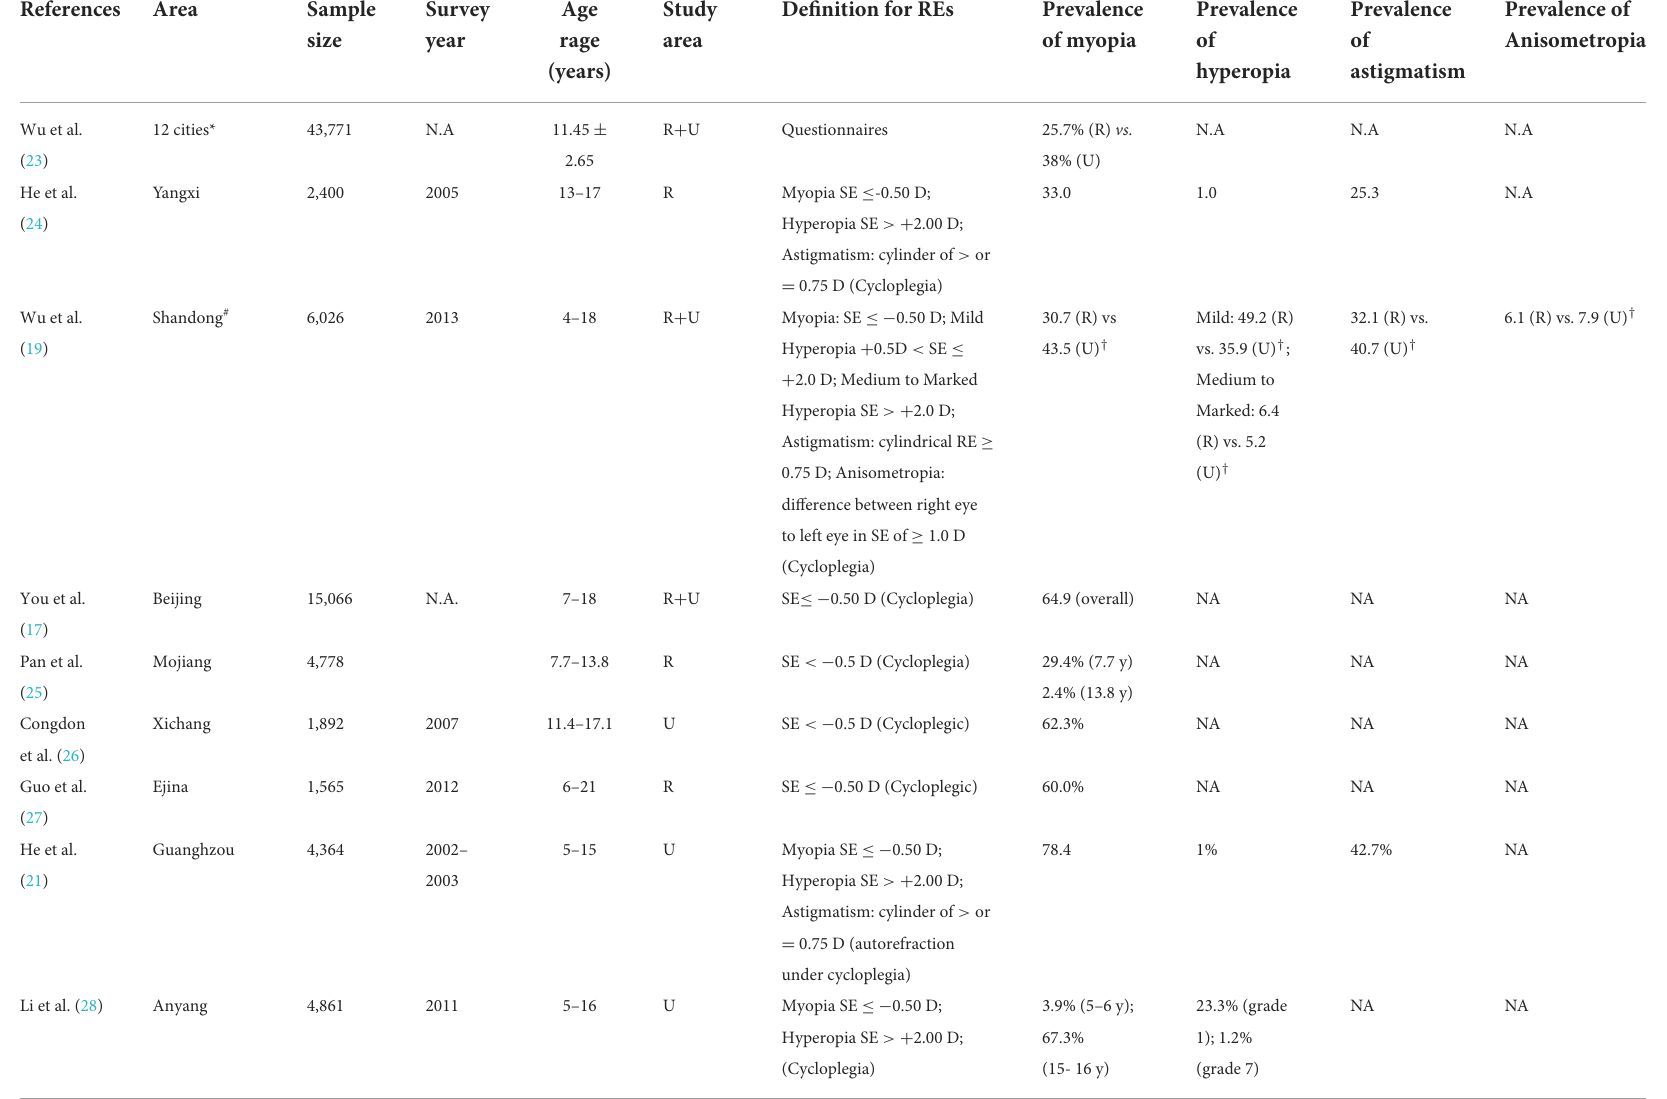
TABLE 5 Comparison of the reported prevalence of refractive errors in selected population-based studies in school children and adolescents in mainland